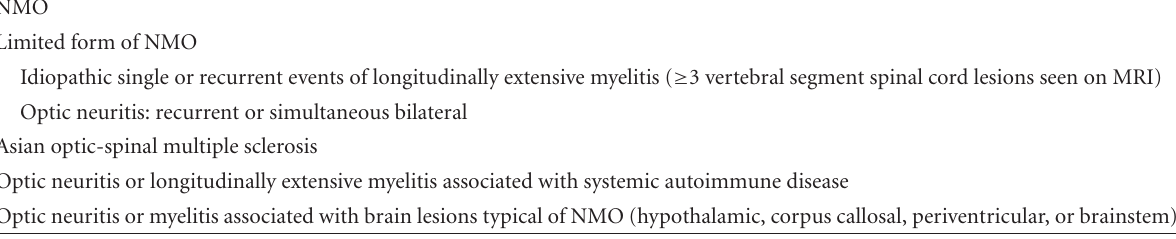
Table 1: NMO spectrum [8].